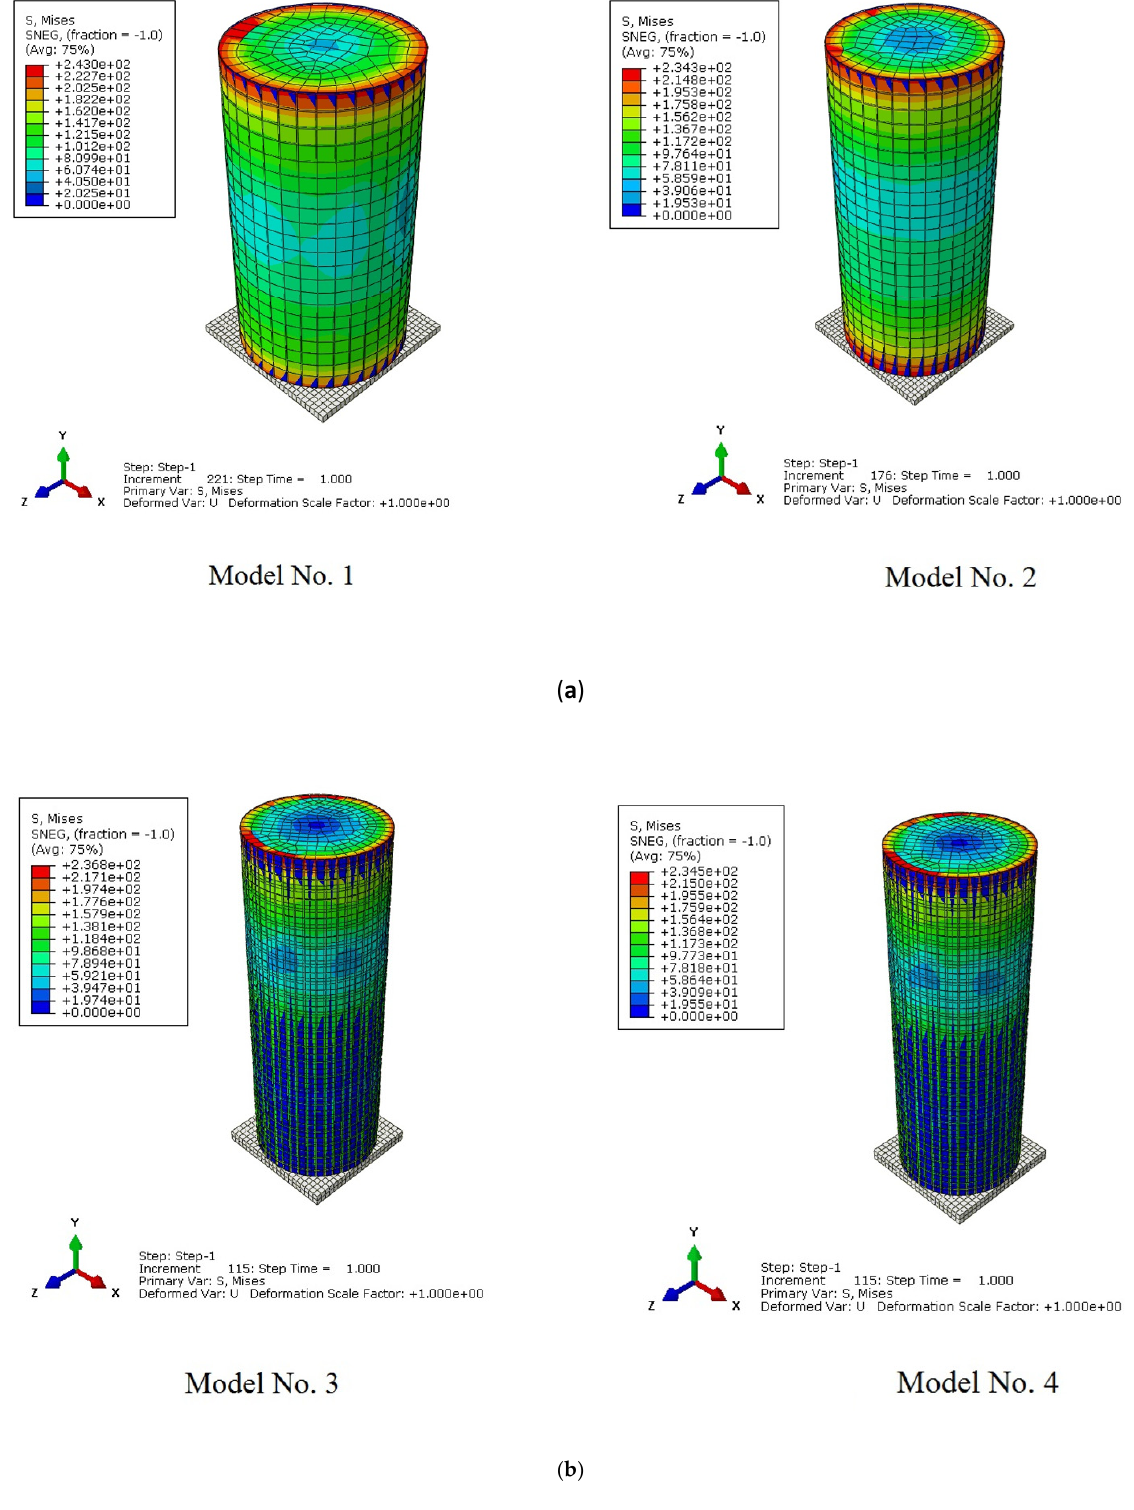
Figure 2. ( a ) FE modelling of Model No. 1 with PFE 3171 kN; Model No. 2 with PFE 2640 kN; ( b ) FE modelling of Model No. 3 with P FE 7919 kN; Model No. 4 with P FE 7928